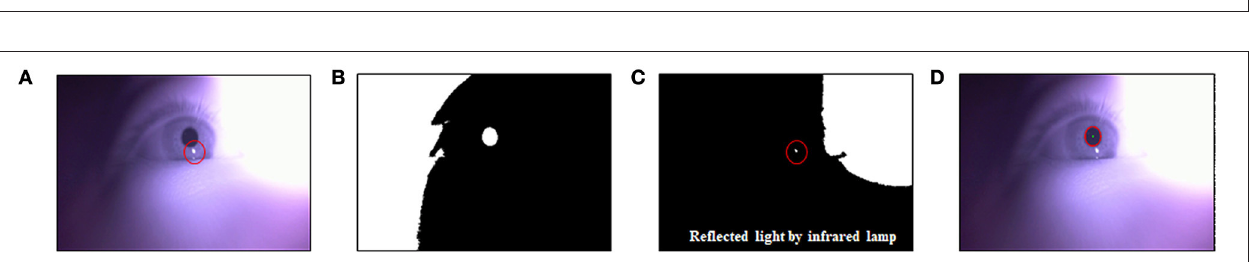
FIGURE 2 | Signal processing for detecting the electroencephalogram (EEG) spectral index from pupillary response and electrocardiograph signals. (A) Pupil diameter at 125 fps. (B) Resampled pupil diameter at 1Hz based on sliding moving average (window size: 125 fps and shift: 125 fps). (C) Band pass filtered signals of each frequency band from the delta to SMR band with harmonic frequency of 1/100f. (D) Spectral power for each band from pupillary rhythm using fast Fourier transform analysis. (E) Relative powers calculated using the ratio between total and each band power. (F) Raw EEG signals. (G) Band pass filtered signals of 1–50Hz. (H) EEG spectrum analysis and extraction of each band power (from delta to SMR). (I) Relative power of each band from EEG signals (ground truth).